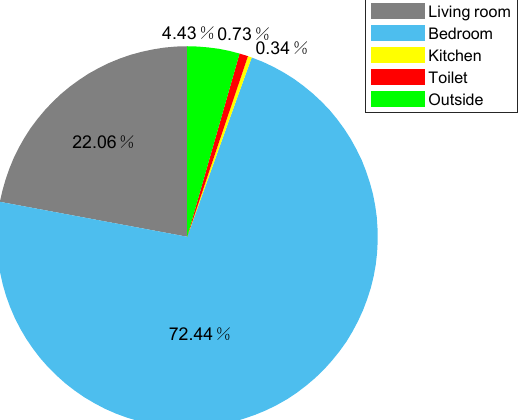
( b ). Figure 17. The averaged activity intensity and the corresponding activity level of the three types of daily activities. ( a ) The averaged activity intensity of the three types of daily activities; ( b ) The activity level of the three types of daily activities. As the WiMonitor system can continuously monitor and record human vitality infor- mation in real time, we can analyze the overall activity level of the elderly during one day or even longer to mine the daily living habits and find abnormity. 5.3. Statistical Analysis of 22 Days Human Vitality Information Since WiMonitor system recorded 22 days of continuous 24 h of human vitality in- formation data from four volunteers, in this subsection, we can analyze these data over 24-h from different perspective to capture the living habit patterns of different volunteers. It is well known that in the smart home environment, physical activities are area- related, such as sleeping usually takes place in the bedroom, and cooking usually takes